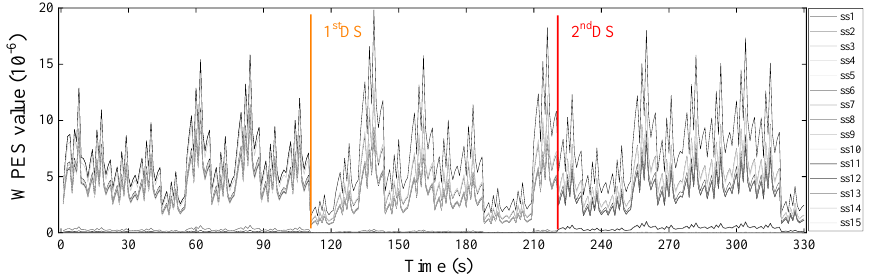
Figure 7. The extracted WPES values from raw strain monitoring data of all the strain sensors.